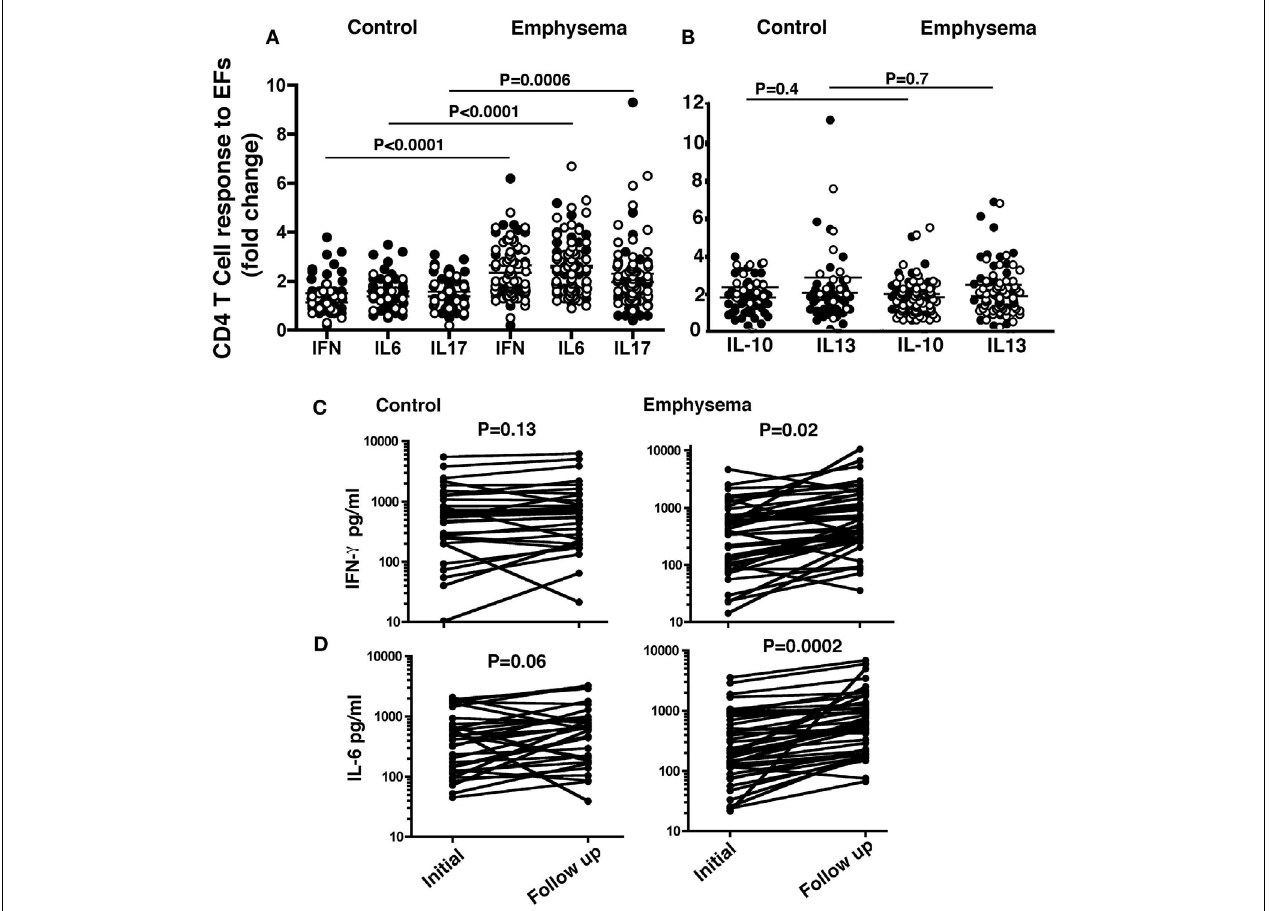
(vehicle) conditions. Each circle represents one volunteer; open circles: former smokers; closed circles: current smokers. Using the sameT cell and APC conditions, the concentrations of IFN- γ (C) and IL-6 (D) were measured from EF-stimulatedT cells obtained during a second clinic visit (range 10–24months following the initial measurement) from emphysema ( n = 45) and control ( n = 32) volunteer. P values as indicated were determined by the Mann–Whitney